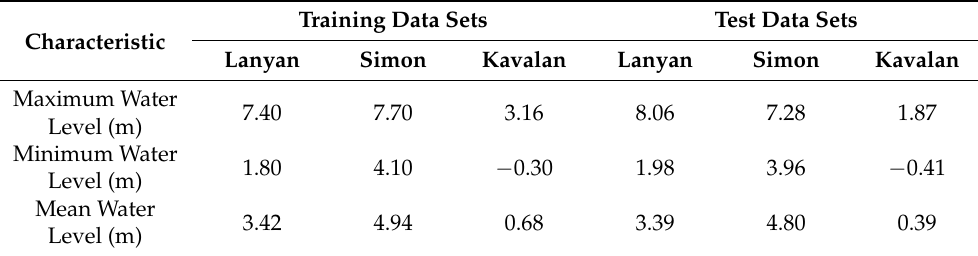
Table 2. The hydrological statistics of the collected data in the study area. Training Data Characteristic